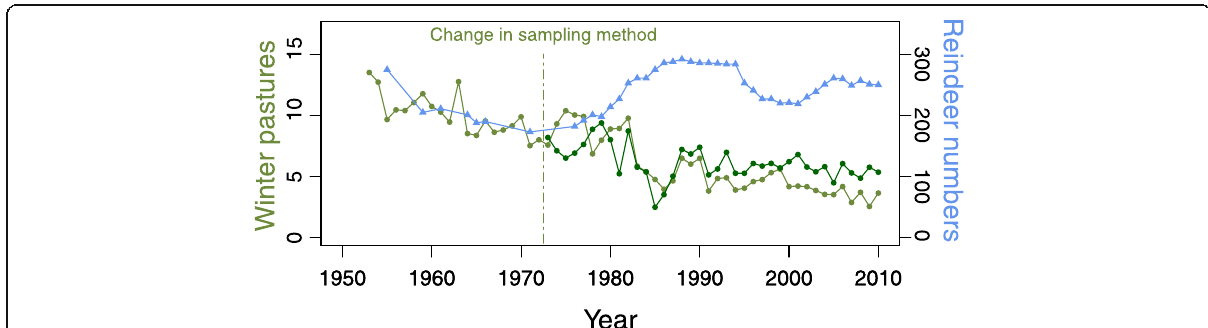
Fig. 2 Change in winter pasture and reindeer numbers in Sweden from 1953 to 2010. Time series of the percentage of Swedish National Forest Inventory (NFI) plots classified as lichen-abundant (light green dots) or lichen-moderate (dark green dots), and of the number of reindeer in the winter herd (after harvest), expressed in thousands of animals (blue triangles). The vertical, green dashed line indicates that NFI data for the period 1953 – 1972 are not directly comparable to data from 1973 to 2010. For a description of data sources and methods used to derive this figure, see Additional file 1